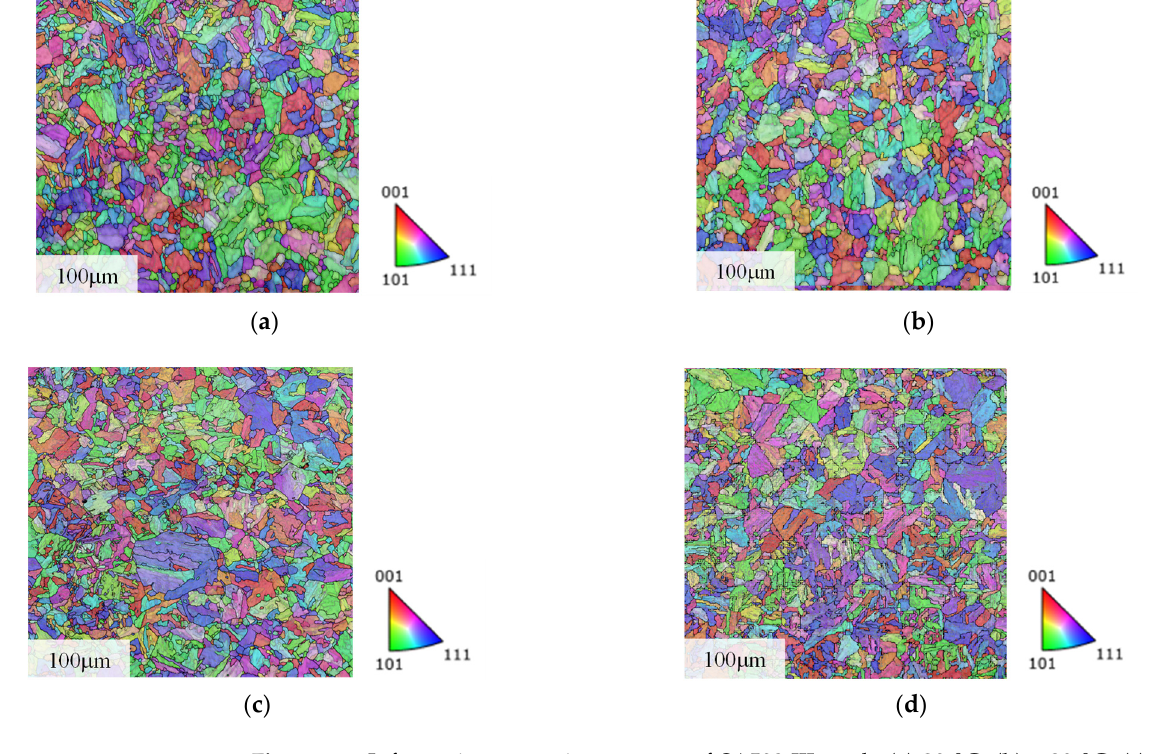
Figure 19. Information on grain structure of SA508- Ⅲ steel. ( a ) 20 °C; ( b ) − 20 °C; ( c ) − 60 °C; ( d ) − 100 °C.